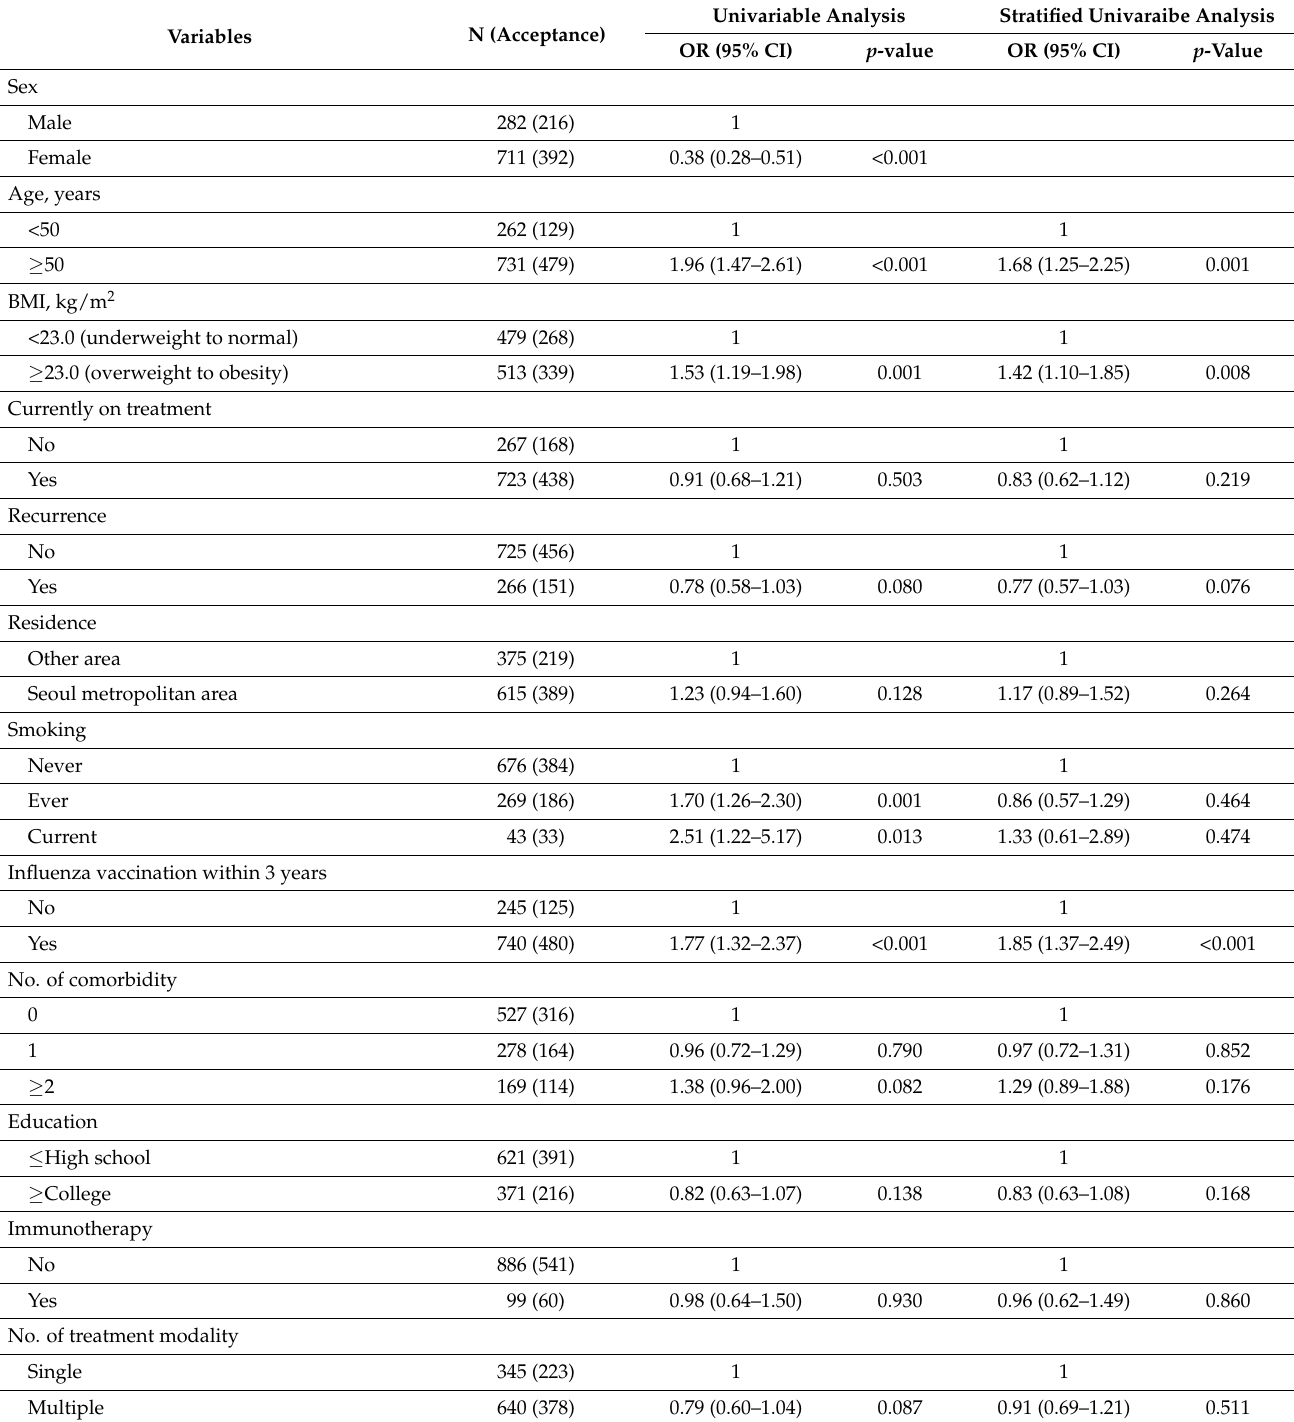
Table 4. Results of univariable analyses for COVID-19 vaccination